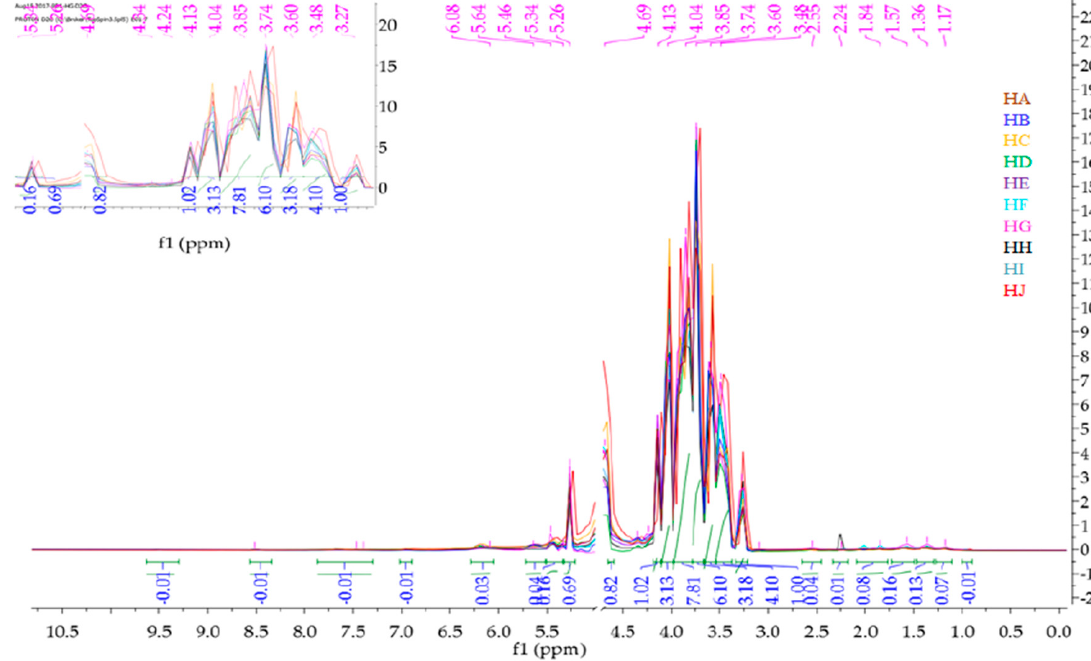
Figure 1. Superimposed and binned full 1 H-NMR spectra of honeys HA-HJ (10.5–0 ppm) in D 2 O , using Mnova 12 NMR software.